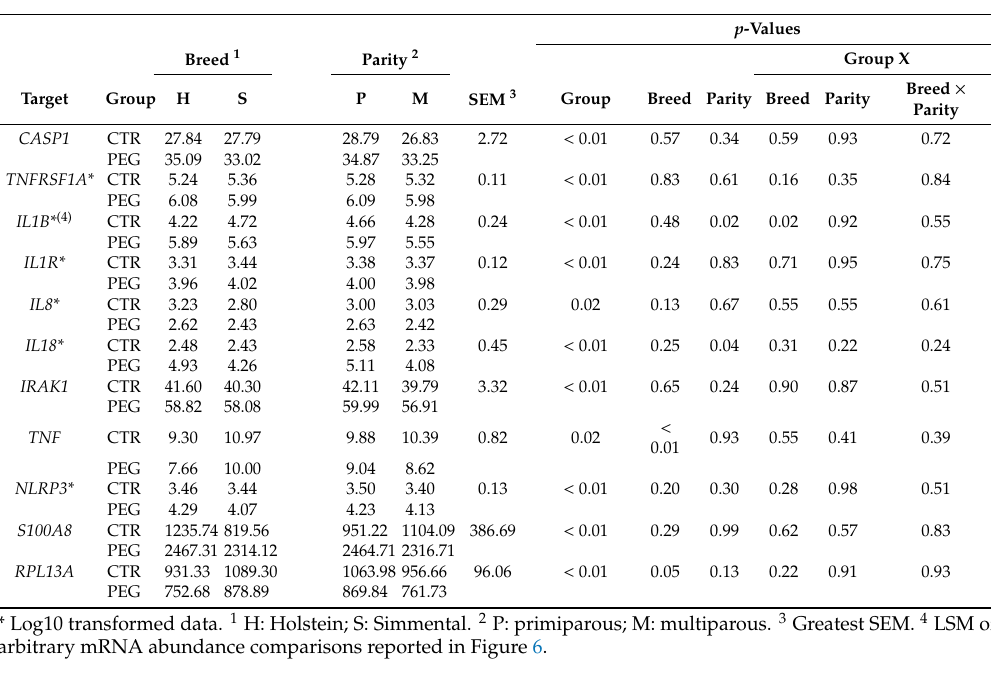
Table 4. LSM of arbitrary mRNA abundance for genes related to the inflammatory cascade in whole blood leukocytes evaluated 3 days after calving from Simmental and Holstein cows treated with pegbovigrastim (PEG) or with saline (CTR) at approximately Day 7 relative to calving and within 24 h the day of calving.